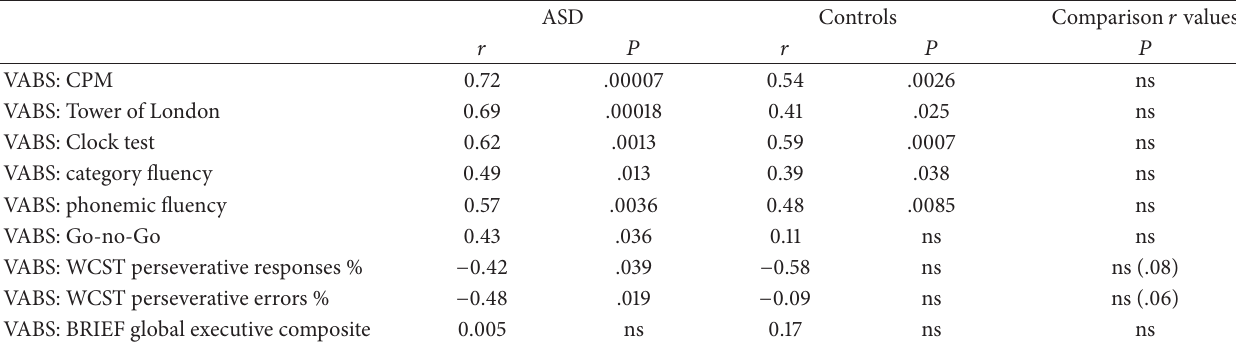
Table 6: Correlations between adaptive and executive functioning in the experimental and control groups (ANCOVA—partial correlation coefficients) and 𝑟 values